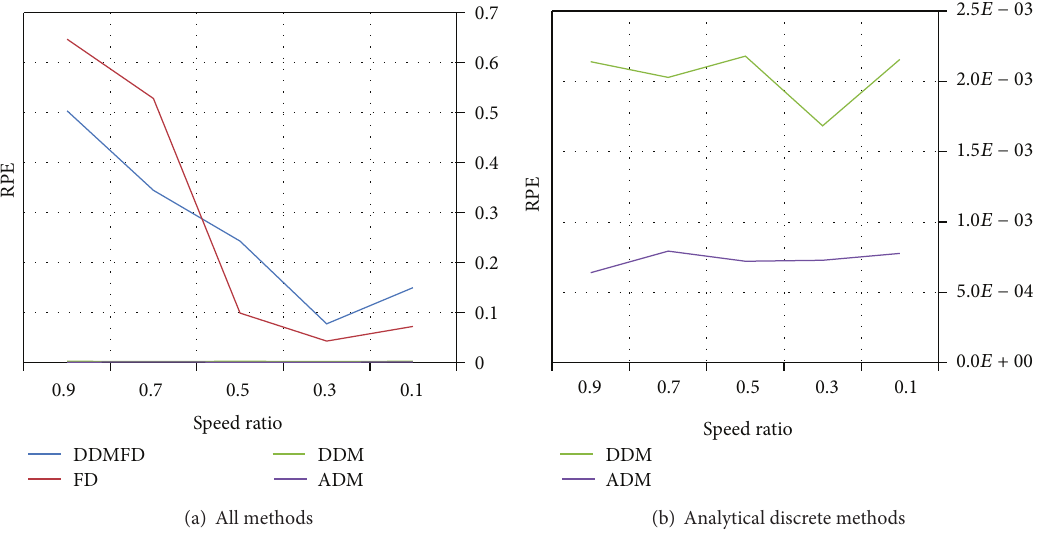
Figure 10: Comparison of RPE between different sensitivity